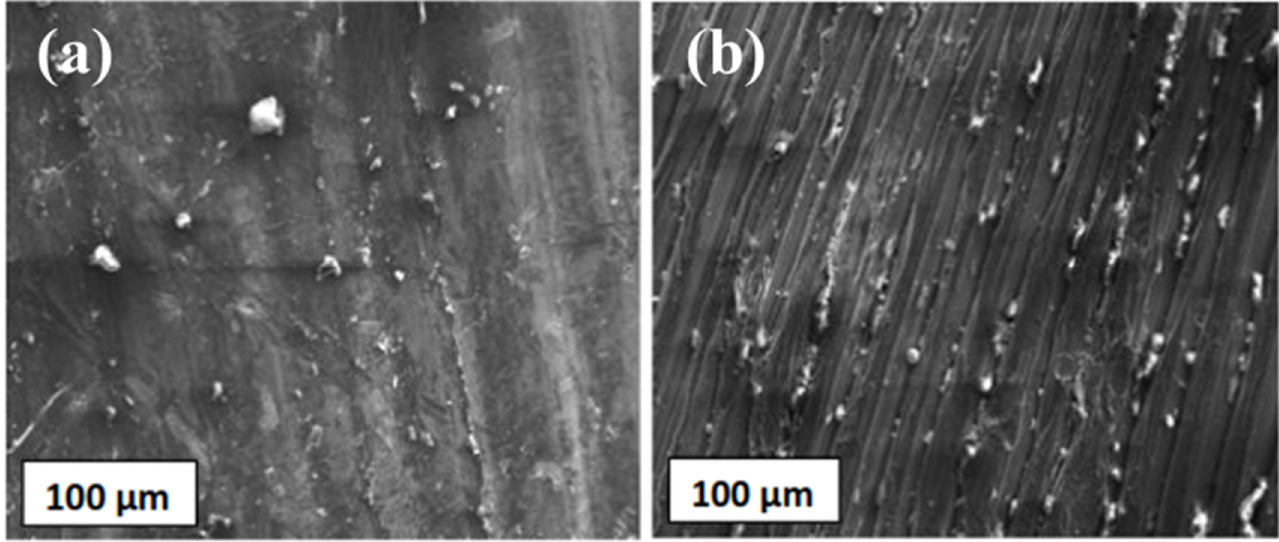
Figure 12. High-resolution SEM images of dynamic recrystallized zones of Al-MMC: ( a ) stir zone, ( b ) onion rings.